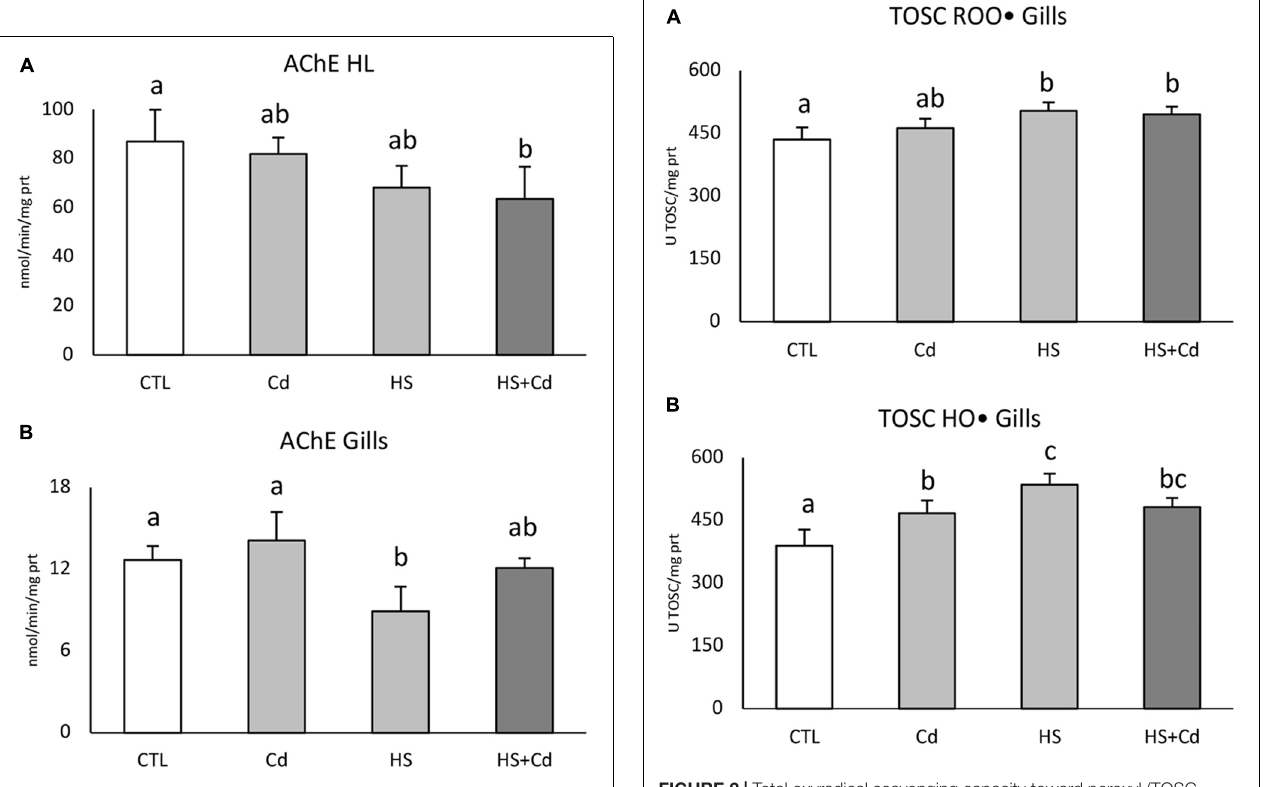
FIGURE 1 | Acetylcholinesterase activity in hemolymph (A) and gills (B) of exposed mussels. Values are given as nmol/min/mg of protein, mean ± standard deviation, n = 4. Letters are used to highlight significant differences between group of means, CTL, Control; Cd, Cadmium exposure; HS, heat stress; HS + Cd, Cadmium exposure under heat stress.